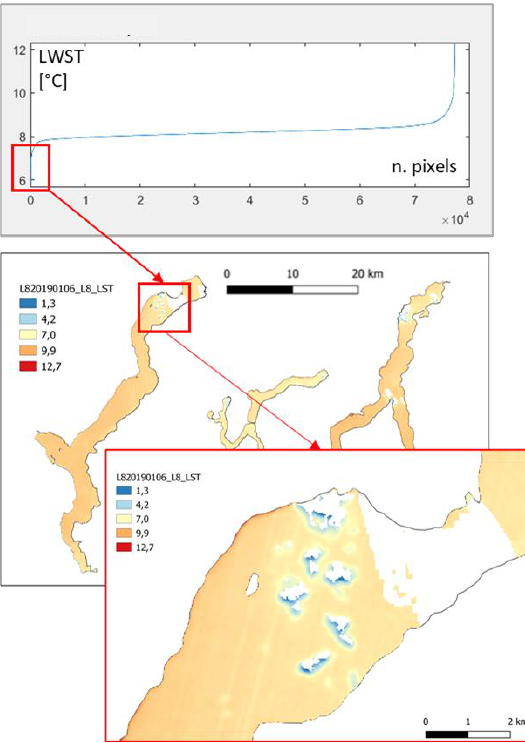
Figure 2 . Out-of-range data filtering, by means of numerical and visual analysis, for the LWST map of 06-01-2019.